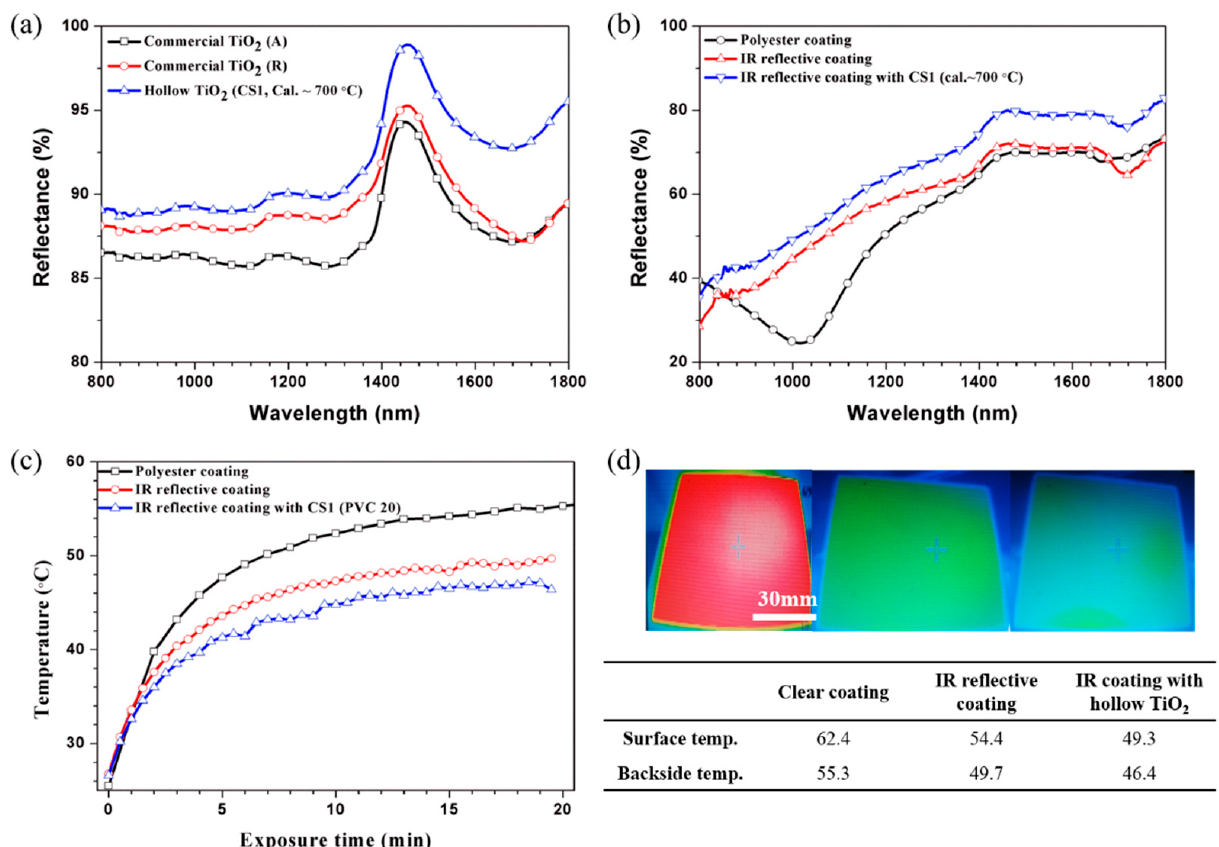
Figure 14. ( a ) UV–vis-NIR reflection spectrum of synthesized hollow particles; ( b ) their coating; ( c ) backside temperature profile of coated steel sheet with/without hollow titania, and ( d ) surface images measured by a thermal detection camera.